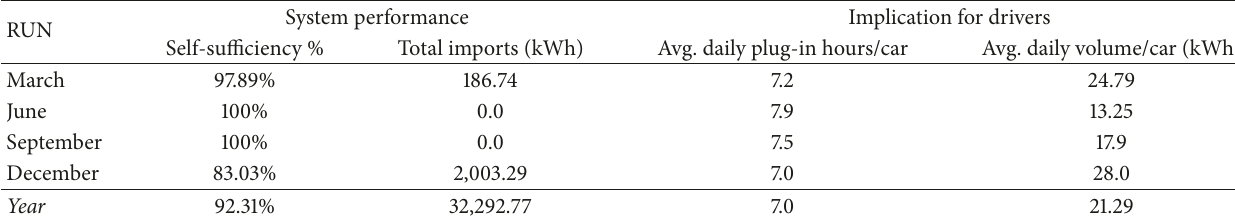
Table 7: Results: system and driver performance.